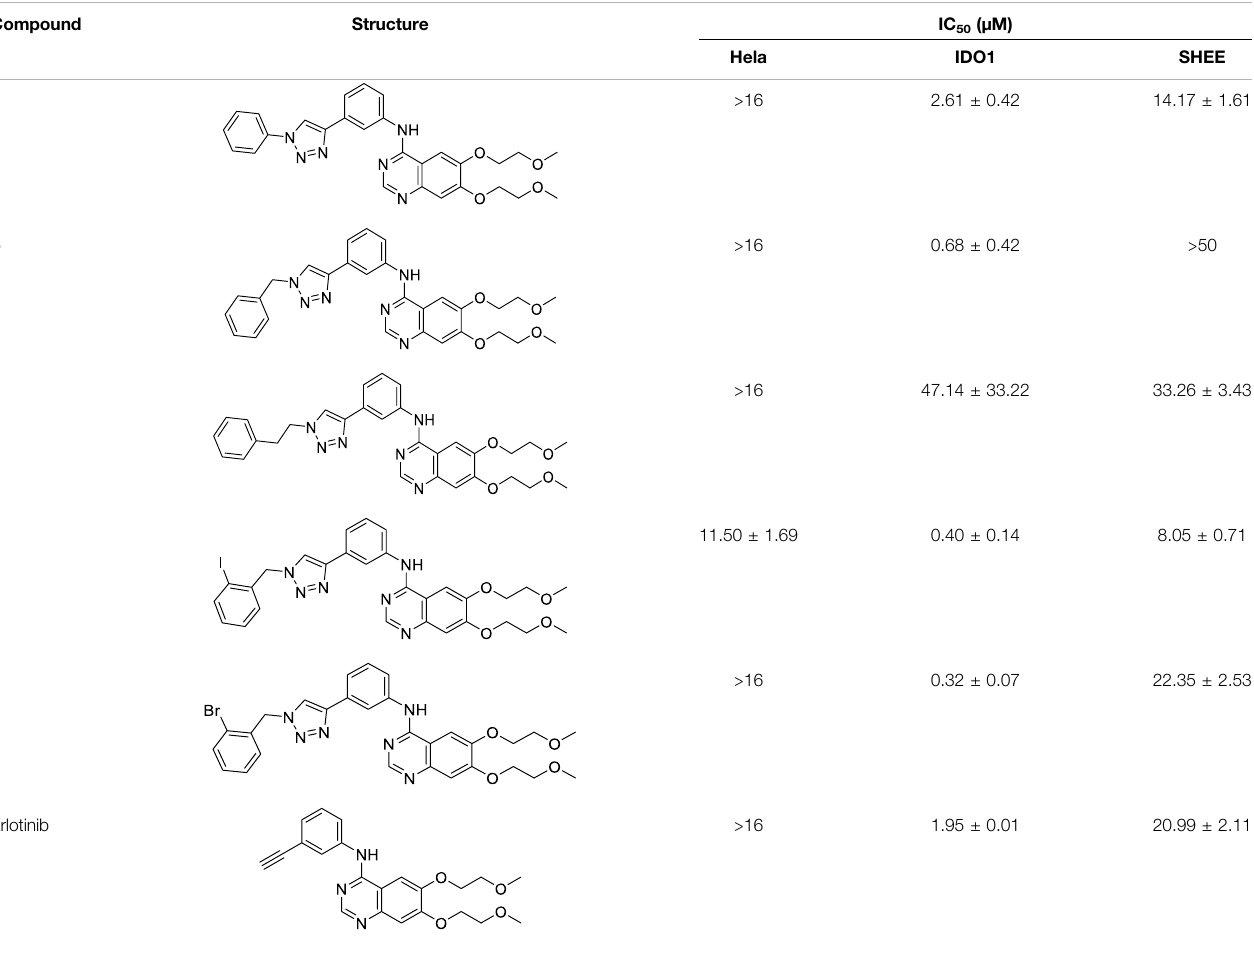
TABLE 3 | IDO1 inhibitory and anti-tumor activities of compounds a – e .